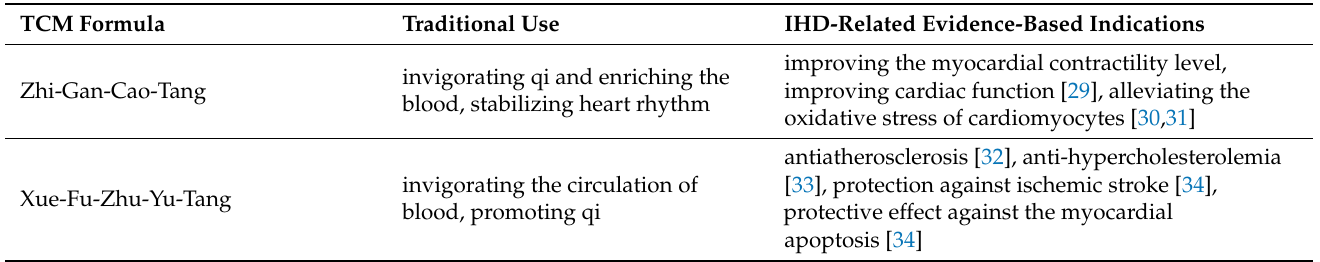
Table 5. The traditional use and evidence-based indications for each TCM formula related to